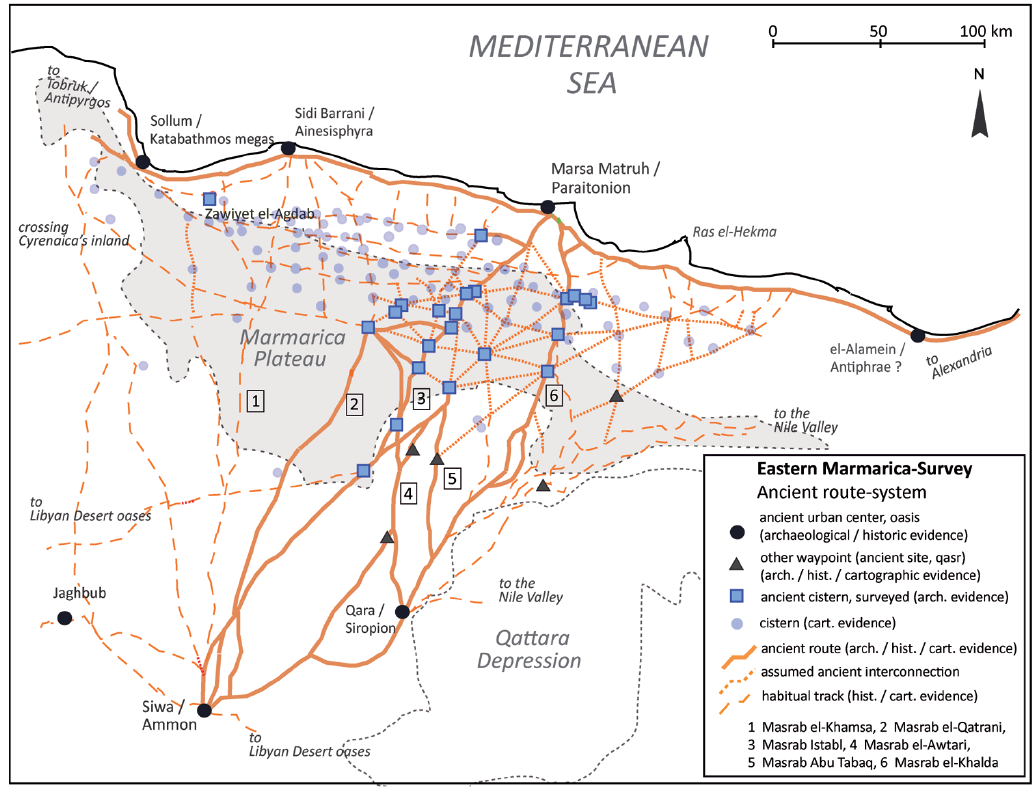
Fig. 16. Map of the route network covering the Marmarica-Plateau in Graeco-Roman times (on base of Rieger, Möller in print Fig.